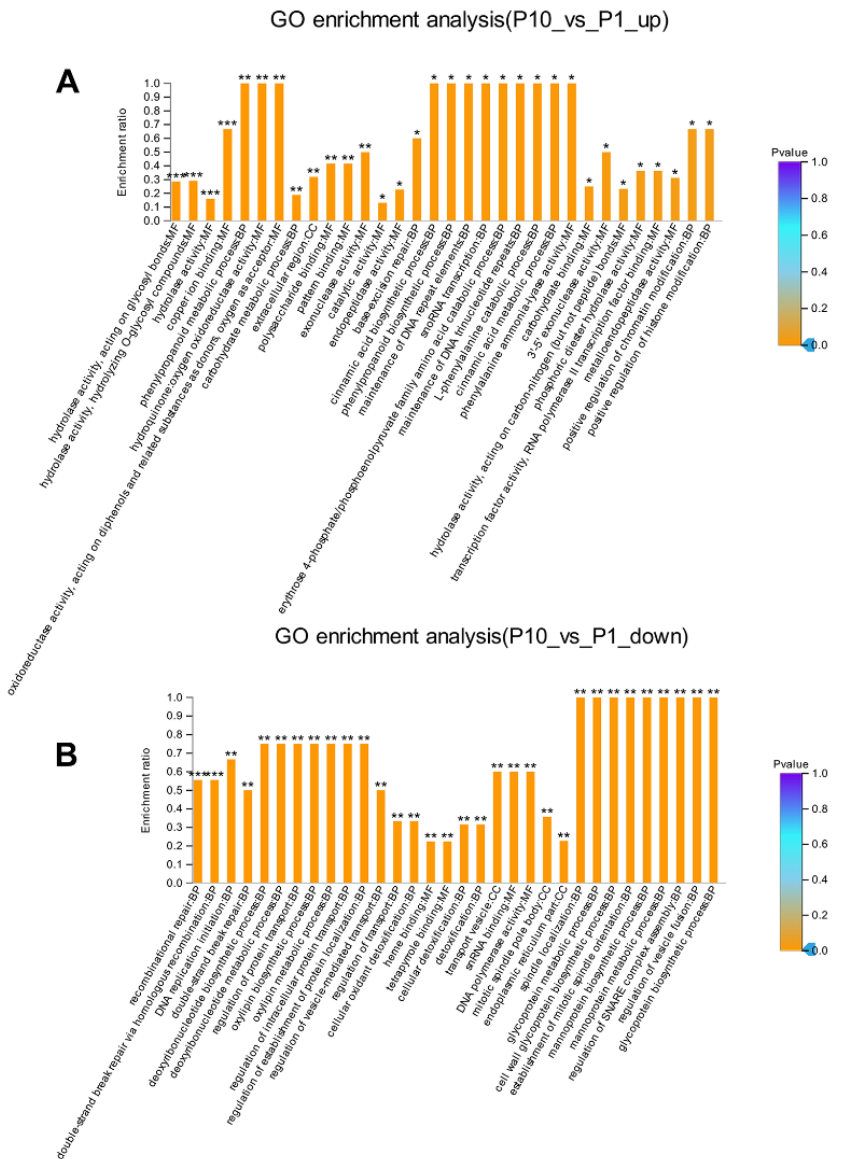
Figure 3. GO enrichment analysis of the up-regulated ( A ) and down-regulated ( B ) DEPs. * p -value < 0.05, ** p -value < 0.01, *** p -value < 0.001.